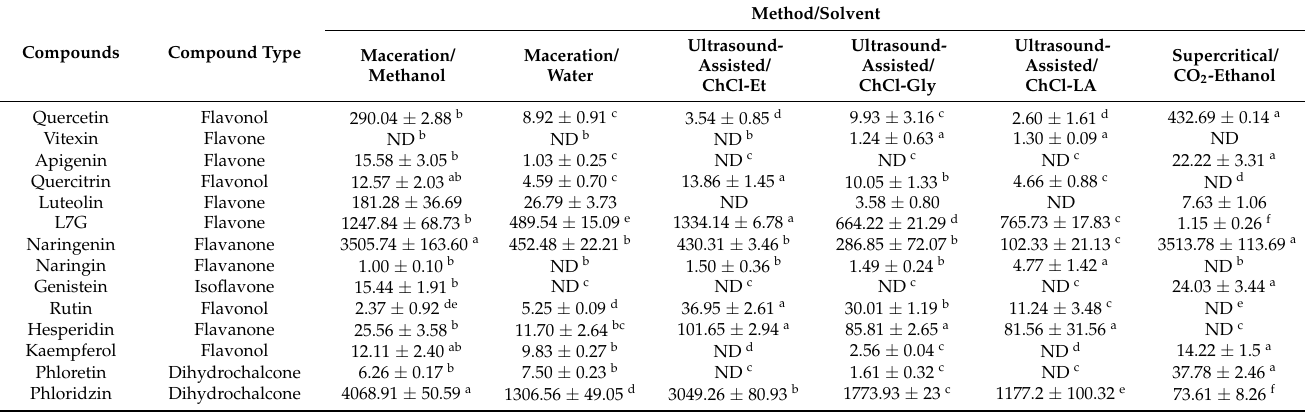
Table 2. Identification and quantification of flavonoids in oregano ( Lippia graveolens )